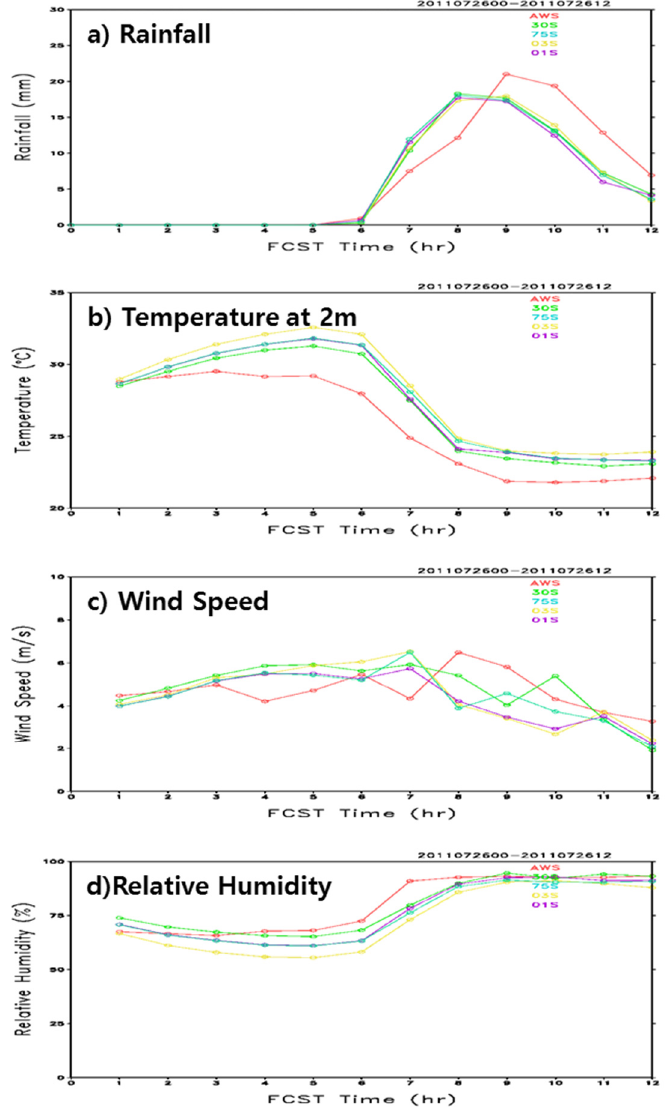
Figure 8. Time series for ( a ) rainfall, ( b ) temperature, and ( c ) wind speed from 0000UTC 26 July 2011 to 1200UTC 26 July 2011 for AWS (red), Control (green), 75 S (light blue), 03S (yellow), and 01S (red).